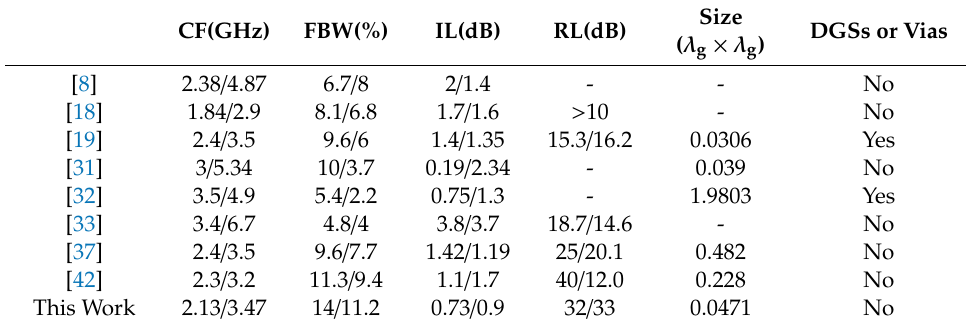
Table 1. Performance comparison with other dual-band BPFs. CF: center frequencies, DGS: defective ground structures, FBW: fractional bandwidth. IL: insertion loss. RL: return loss.